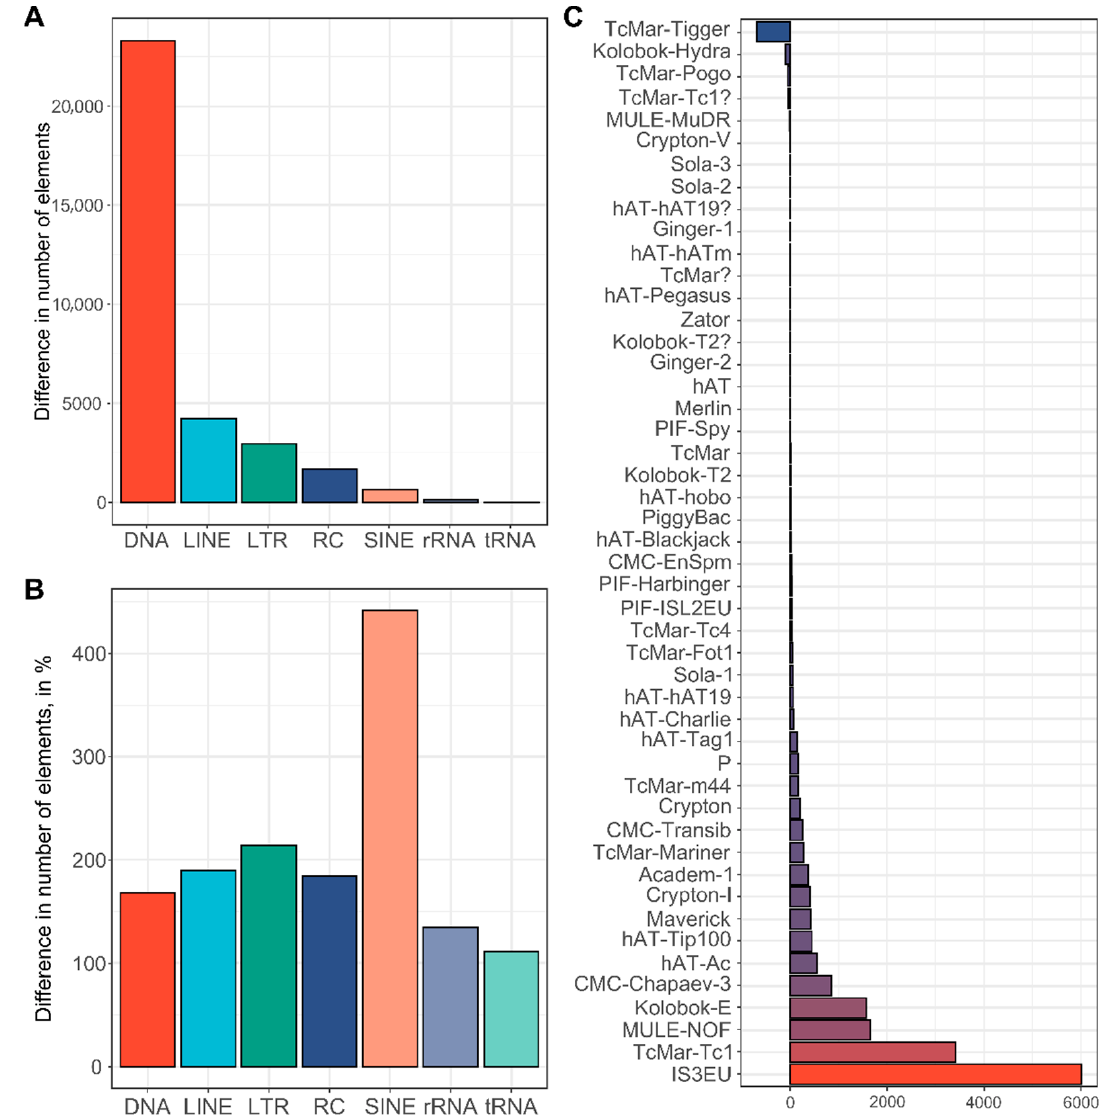
Figure 6. Distribution and evaluation of interspersed elements in the Tfree1.0 assembly in comparison to the Tcas5.2 assembly. ( A ) Profile of annotated interspersed elements in Tfree1.0 expressed as the difference in absolute number of elements annotated in Tfree1.0 and Tcas5.2. ( B ) Difference in number of interspersed elements in Tfree1.0 compared to Tcas5.2, expressed in percentages. ( C ) Graph of DNA transposon subclasses in Tfree1.0 plotted as increase/decrease in absolute number of elements compared to same elements present in Tcas5.2 (based on data in Table S6). The analyses were performed on the assembled linkage groups ( T. freemani f LGs and T. castaneum LGs) and the unplaced contigs.